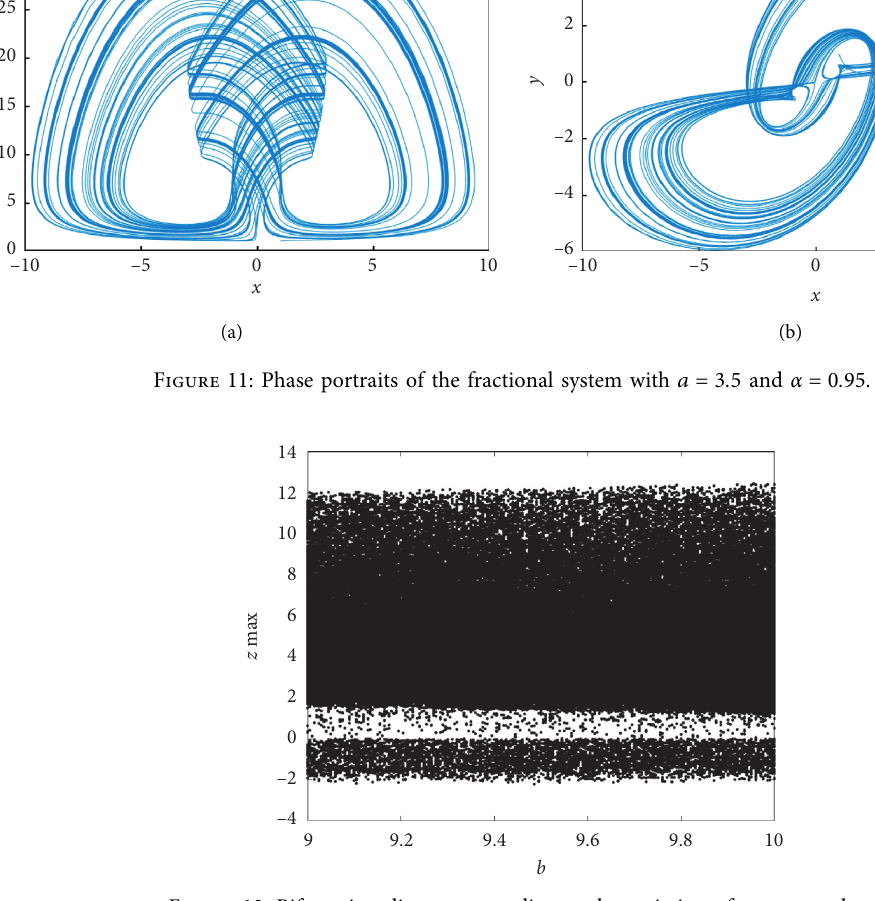
Figure 12: Bifurcation diagram according to the variation of parameter b .